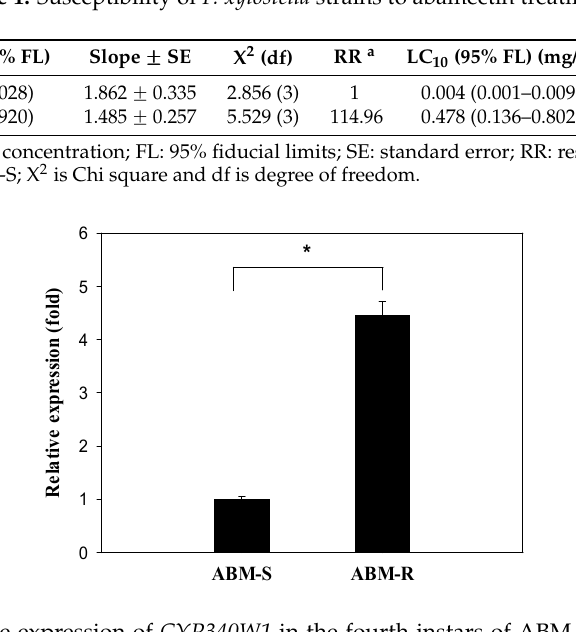
Figure 3. The relative expression of CYP340W1 in the fourth instars of ABM-S and ABM-R in the absence of abamectin treatment. Expression in the ABM-S strain was set to 1. Expression of the elongation factor 1 ( EF1 ) and ribosomal protein L32 ( RPL32 ) genes were used as the internal standard. Values are means and standard errors. The asterisk indicates a significant difference between the ABM-S and ABM-R strain ( p < 0.05; Tukey’s test; n = 3).